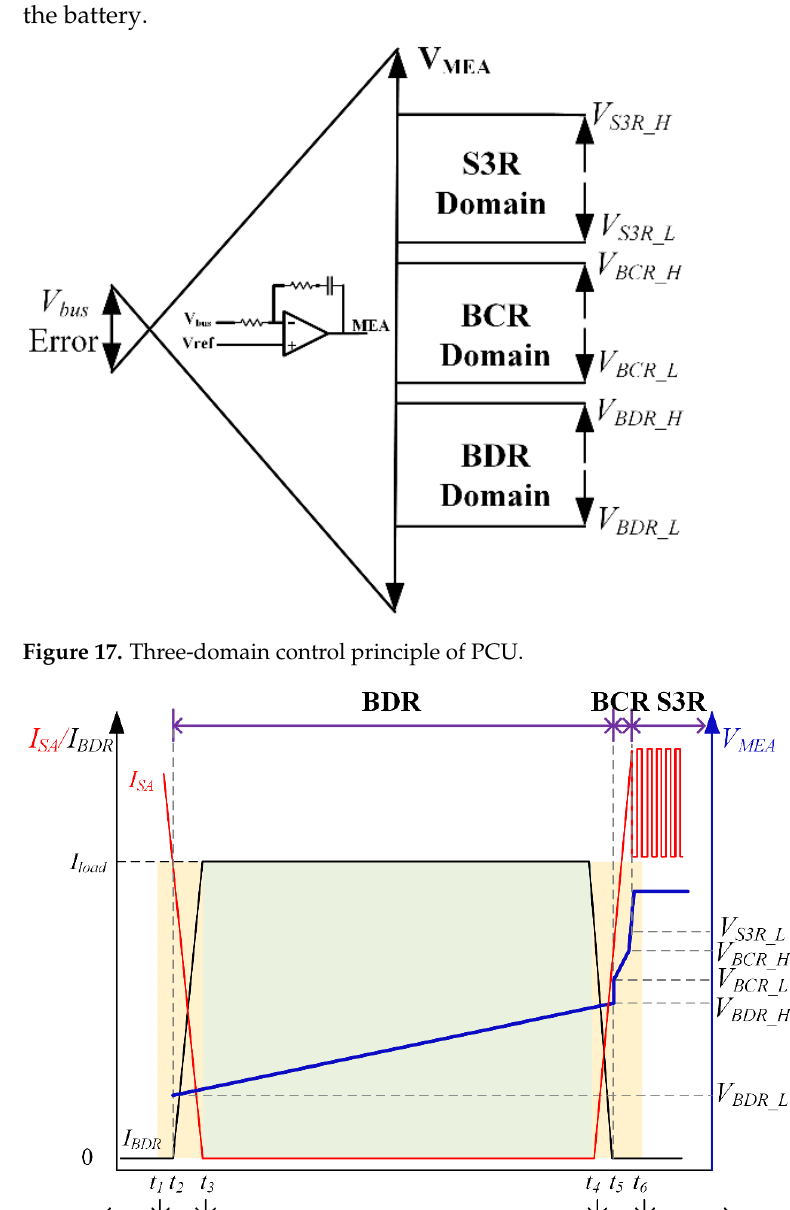
( c ) Figure 16. Satellite loads. ( a ) Constant power load; ( b ) Variable power load; ( c ) Variable power load that switches between two powers over time. 5.2. Hazard–Risk Evaluations The division of PCU three ‐ domain control is shown in Figure 17. The energy of the solar array and the battery is allocated and managed by the V MEA . When the out ‐ put energy of the solar array is constant, but the load varies non ‐ linearly, as shown in Figure 16b, it is usually only regulated within the S3R domain (full ‐ light region) or the BDR domain (umbra region), and there is no need to stabilize the V bus by spanning multiple domains. However, when the load is constant, but the output energy of the solar array varies with the light intensity during the Earth eclipse period, the process of PCU three ‐ domain control is shown in Figure 18. From entering the penumbra region, I SA gradually decreases as sunlight is blocked. When the energy of the solar array is insufficient to meet the load demand, the PCU begins to enter the BDR do ‐ main to control the battery to supply power to the load to stabilize the V bus . When entering the umbra region, I SA is reduced to 0, and all the energy required by the load is provided by the battery. In the stage of leaving the Earth eclipse, I SA gradually in ‐